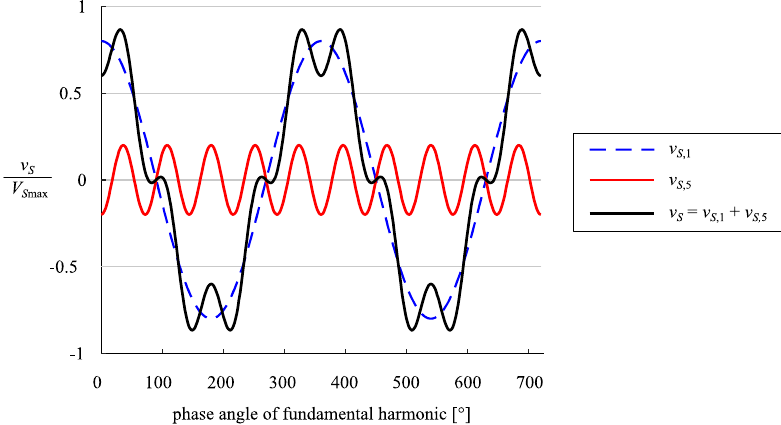
Figure 3. Converter voltage v S consisting of the first and fifth harmonic with the same amplitudes as in Figure 2, but di ff erent phase displacement; no saturation